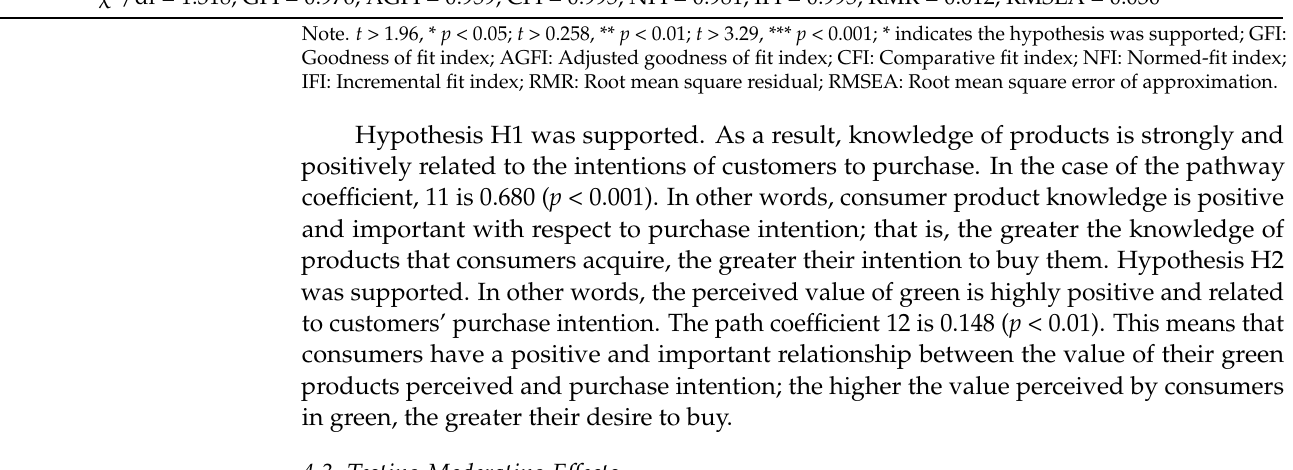
Table 4. The model’s standardized regression weights, t -values, and hypothesis.